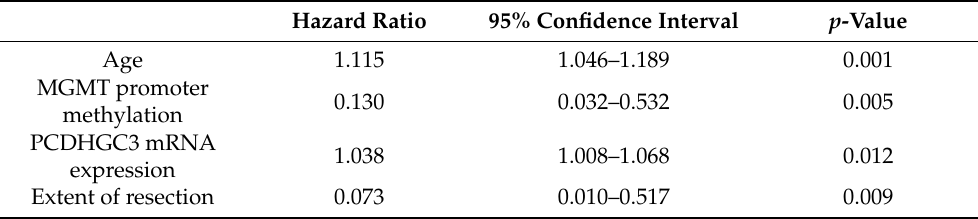
Figure 3. Kaplan–Meier plots of GBM patients and patients with gliomas grade 2/3 based on PCDHGC3 mRNA-expression. Samples were assigned either to the category “low” PCDHGC3 expression or “high” PCDHGC3 expression, based on the median of the mRNA expression. ( a ) Overall survival (OS) of GBM patients ( n = 40, alignment with median = 22.0 months) in months since diagnosis ( p = 0.790, median overall survival 20 vs. 22 months). ( b ) Progression-free survival of patients (PFS) with GBM ( n = 35, alignment with the median = 10.0 months) since the first surgery in months ( p = 0.016, median progression-free survival 7 vs. 12 months). ( c ) Overall survival (OS) of patients with gliomas grade 2/3 ( n = 20, alignment with median = 41.0 months) in months since diagnosis ( p = 0.168, median overall survival 37 vs. 72 months). Table 3. Multivariable Cox proportional hazard model for the OS of GBM patients.